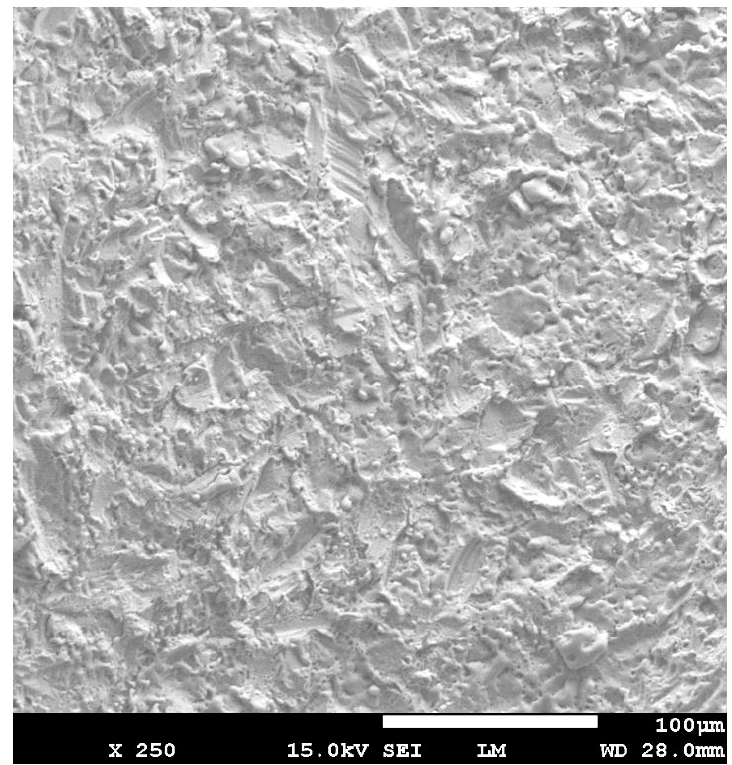
Figure 5. SEM view of the group S showing the relief and the roughness of the surfaces of a sterile implant.